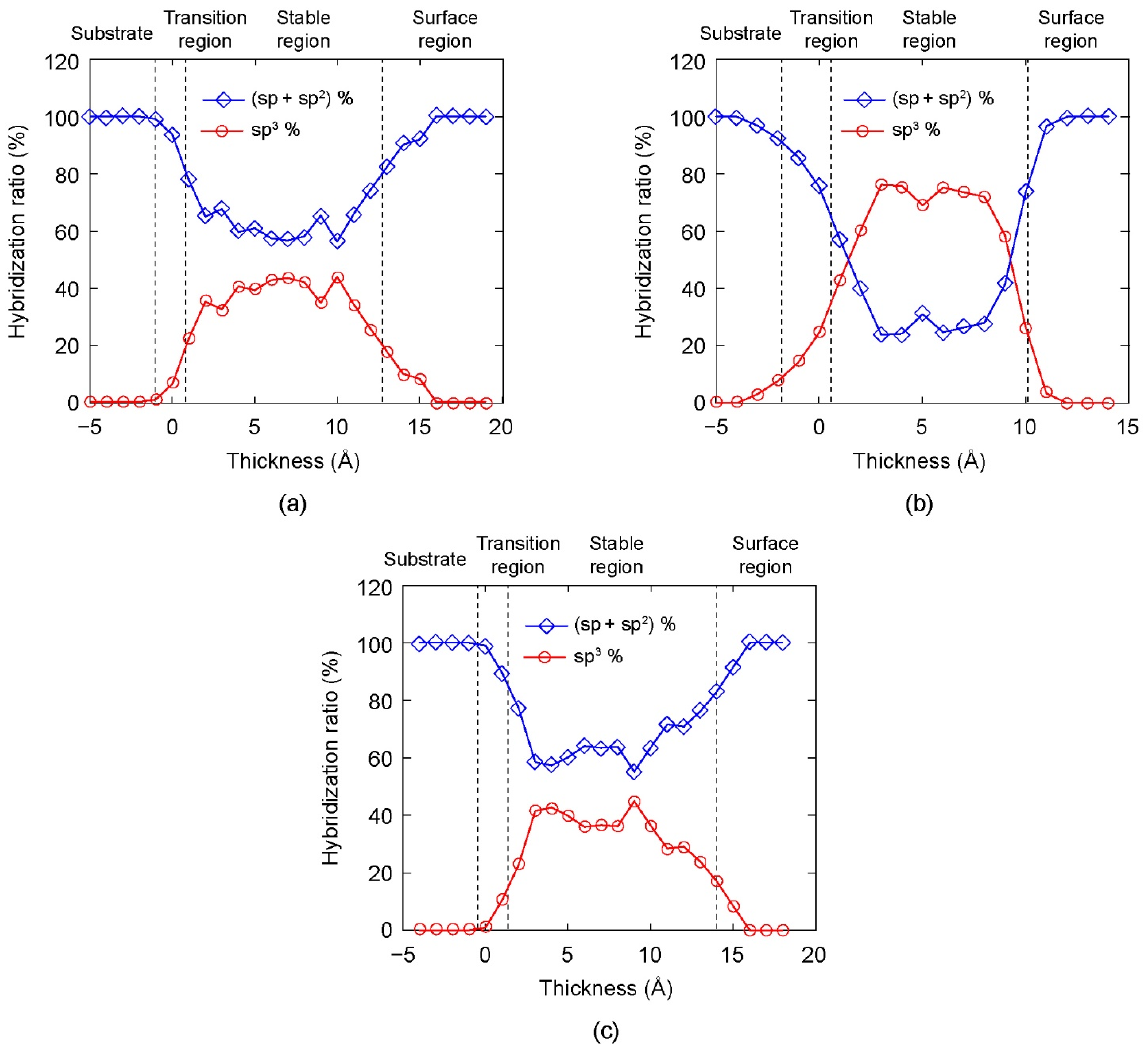
Figure 5. The hybridization ratio along the thickness direction of DLC film under different substrate bias voltages: ( a ) 0 V, ( b ) 120 V, and ( c ) 300 V.